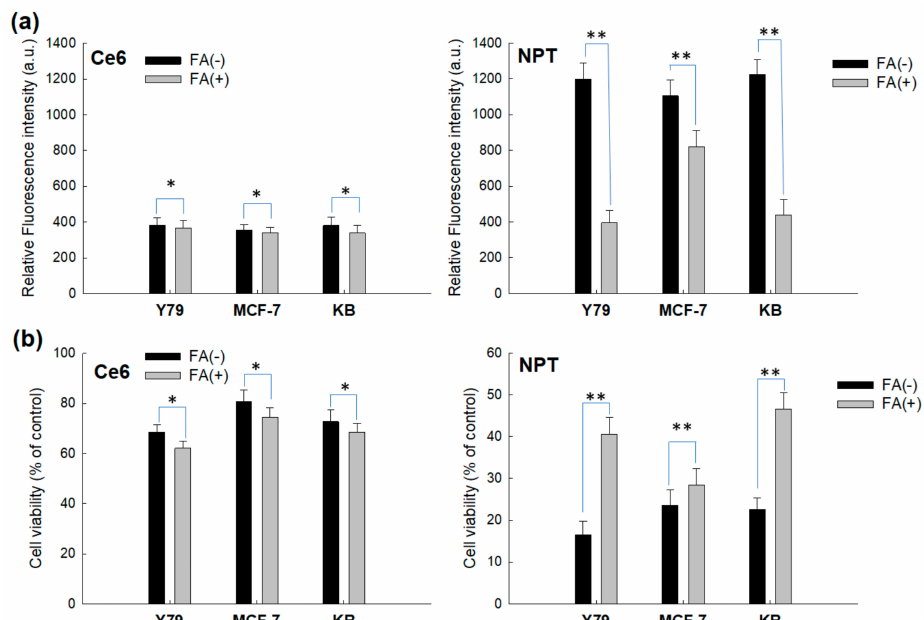
Figure 9. The effect of pretreatment of FA on the intracellular ROS generation ( a ) and phototoxicity ( b ). Cells were treated with Ce6 or nanophotosensitizers in a similar manner to Figure 8. FA (5 mM) was pretreated to the cells 30 min before free Ce6 or nanophotosensitizer treatment. Ce6 concentration was 2 µ g/mL. Cells were exposed to free Ce6 or nanophotosensitizers for 2 h and then irradiated at 664 nm (2 J/cm 2 ). *, ** p <